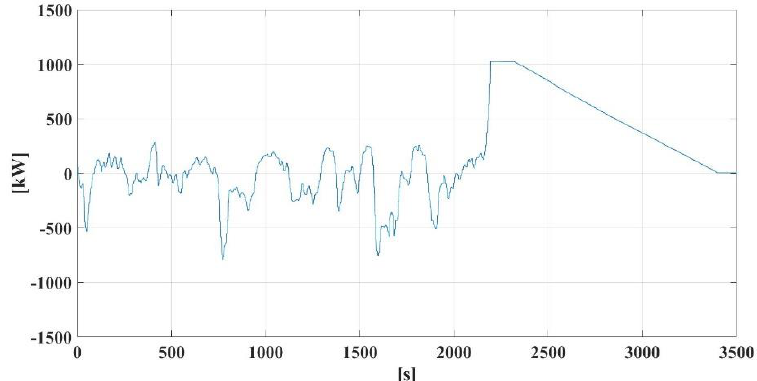
Energies 2020 , 13 , x FOR PEER REVIEW